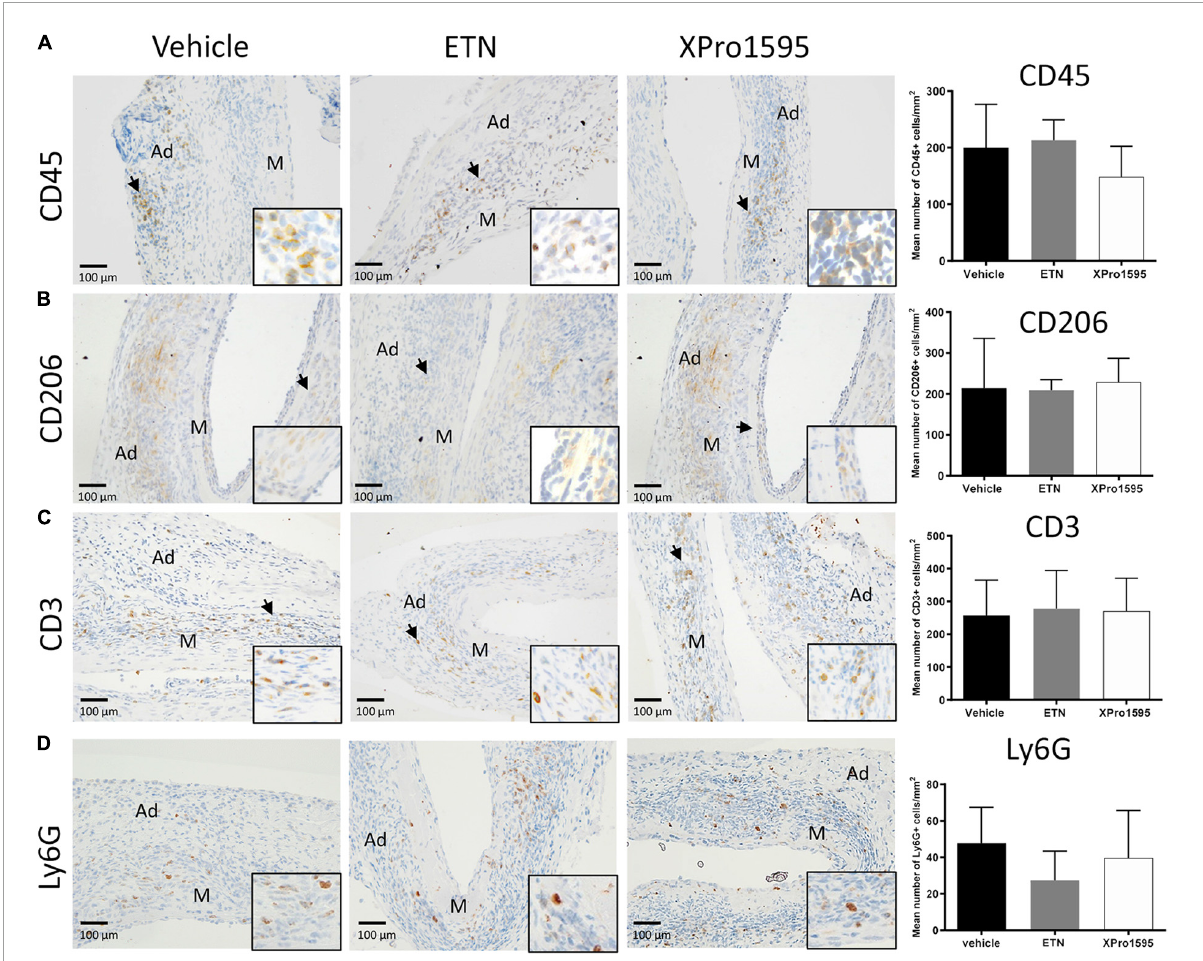
FIGURE3 Effect of TNF inhibition on infiltrating immune cells 14 days after PPE-induced AAA formation. Representative micrographs after TNF inhibition showing the distribution of infiltrating immune cells (left) and semi-quantification (right, number of positive cells/mm 2 ) of CD45-positive leukocytes (A) , CD206-positive M2-like macrophages (B) , CD3-positive T-cells (C) , and Ly6G-positive neutrophils (D) in the aneurysm wall after TNF inhibition ( n = 3–5). Black arrowheads indicate positive stained cells. Data are shown as mean SEM. None of the semi-quantifications reached significance on one-way ANOVA using Bonferroni test for multiple comparisons. M, media; Ad,